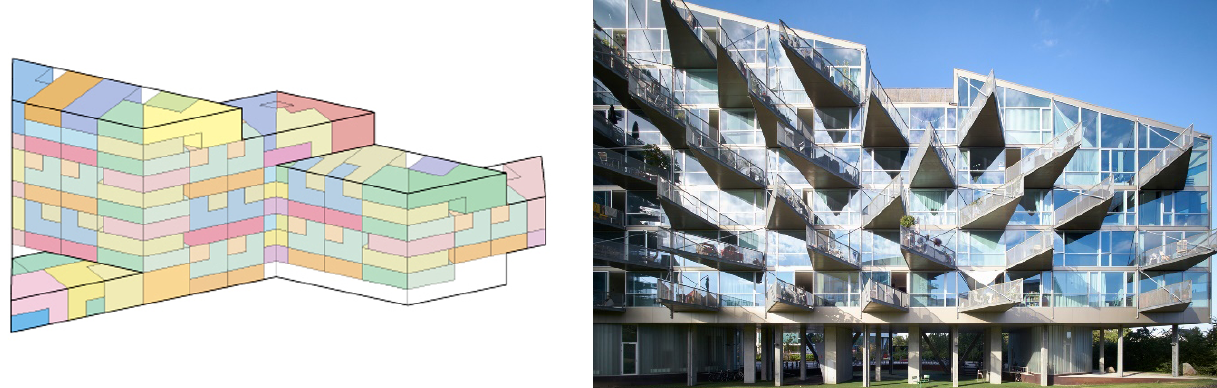
Figure 16. The VM Tetris-packaging method of the variant apartment versus the ‘dress’ covering the verity. Sources: BIG and VM Houses (n.d) and BIG + JDS